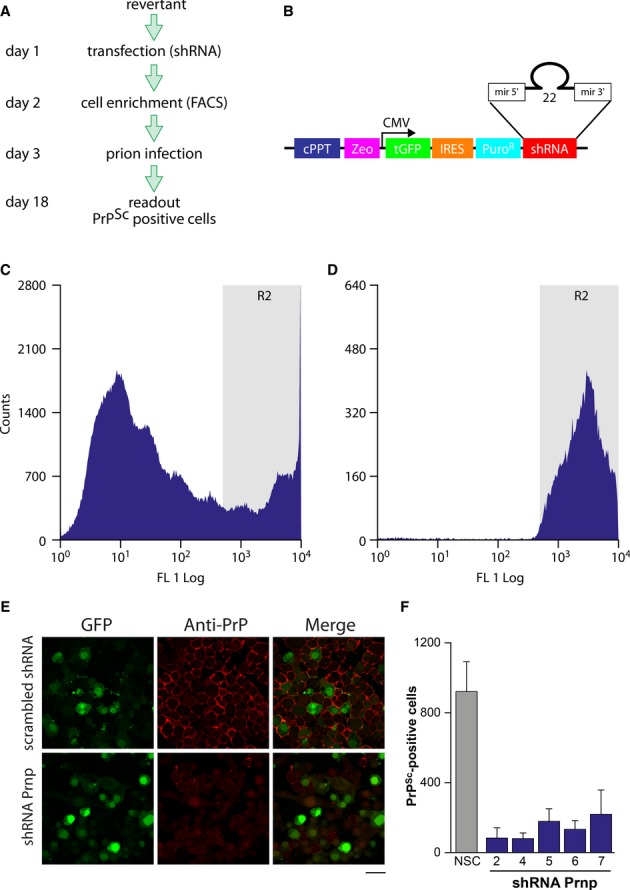
A gene silencing approach to validate genetic modifiers of prion propagationA Schematic representation of RNAi validation.B pGIPZ vector used for bicistronic expression of shRNA and GFP.C, D Enrichment of shRNA-expressing cells by gating highly GFP-positive cells using FACS. Fluorescence profiles of transfected cells before (C) or after (D) FACS enrichment of GPF-positive cells are shown.E Gene silencing of Prnp abrogates PrP protein expression at the plasma membrane. Revertant R7 cells were silenced with control shRNA (scrambled shRNA) and shRNA Prnp, enriched for GFP-positive cells and plated into chamber slides for immunofluorescence labelling. After 3 days cells were fixed and labelled with anti-PrP antibody ICSM18. Scale bar: 20 μm.F Transient gene silencing of Prnp inhibits prion propagation. Prion-susceptible PK1 cells were transfected with shRNA against Prnp or non-silencing control (NSC), enriched by flow cytometry, plated into 96-well plates at a cell density of 2 × 104 cells/well and 24 h later infected with a 10−5 dilution of RML mouse prions. After three serial cell passages every 3–4 days, the number of PrPSc-positive cells was determined by ELISA. Mean values ± SD are shown; a significant decrease in prion propagation was observed for all shRNAs tested (P < 0.01).